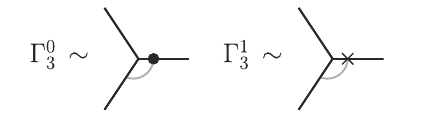
Fig. 3 Diagramtechniqueelementsforthenewthree-vertices(without the ghost field) defined in formula (38)